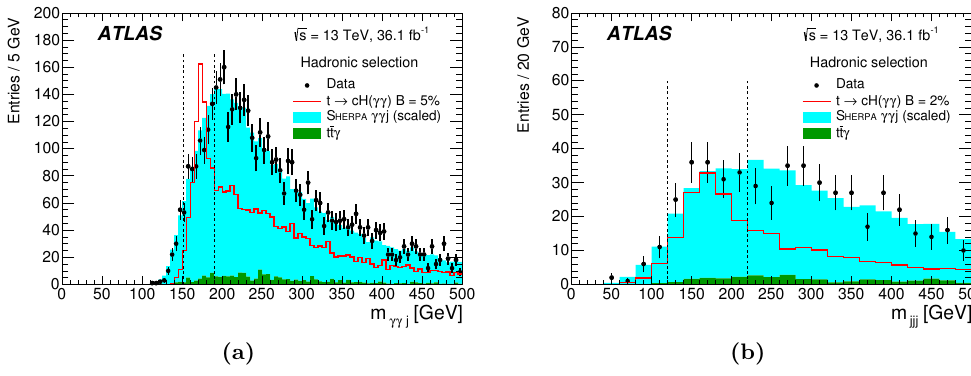
Figure 1. Distribution of the invariant mass of (a) the two selected photons, together with one of the four selected jets (Top1, four entries per event), and (b) the three remaining jets (Top2, one entry per combination ful(cid:12)lling the M 1 selection). At least one b -tagged jet per event is required. The t (cid:22) t(cid:13) distributions, normalised to the data’s integrated luminosity using the theoretical cross section, are superimposed, together with the Sherpa S (cid:13)(cid:13)j contribution normalised to the di(cid:11)erence between data and t (cid:22) t(cid:13) . The signal distributions are normalised assuming a branching ratio of (a) 5% and (b) 2%. The vertical dotted lines indicate the (a) M 1 and (b) M 2 selection windows (see